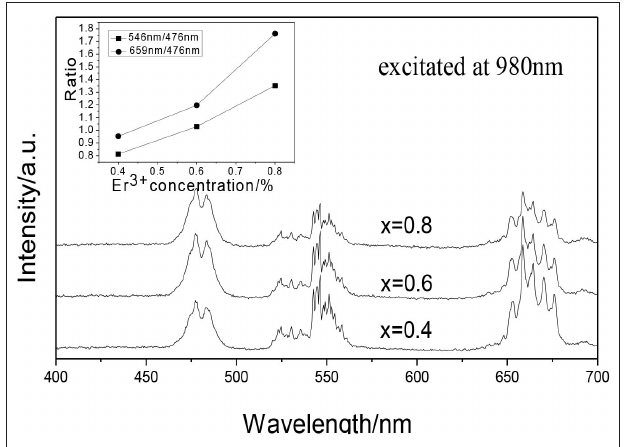
FIGURE 2 | UCPL spectra of the GdAlO 3 : x%Er 3 + , 10%Yb 3 + , 1%Tm 3 + phosphors (inset is the dependence of the 546 nm/476nm and 659 nm/476nm intensity ratio on Er 3 + concentration).